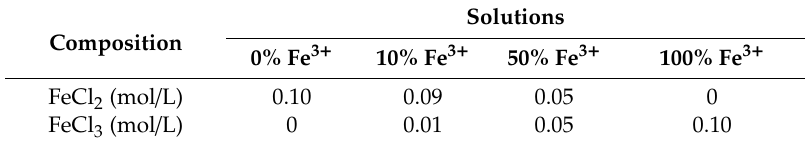
Table 1. The iron ion solution with di ff erent Fe 3 + / Fe 2 + ratios for electrochemical testing. Composition